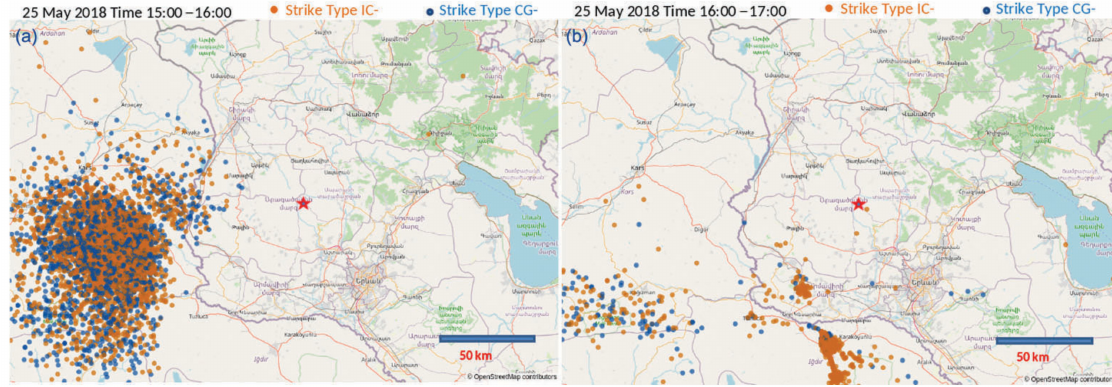
Figure 10. ( a ) Map of lightning flashes obtained with Boltek’s storm tracker on 25 May 2018, before the TGE at 15:00–16:00. The lightning type symbols and storm duration are portrayed in the upper panel, the Aragats research station location is indicated by a red star. ( b ): The “lightning” map observed just before and during TGE at 16:00–17:00 when the light glows appear above the station.